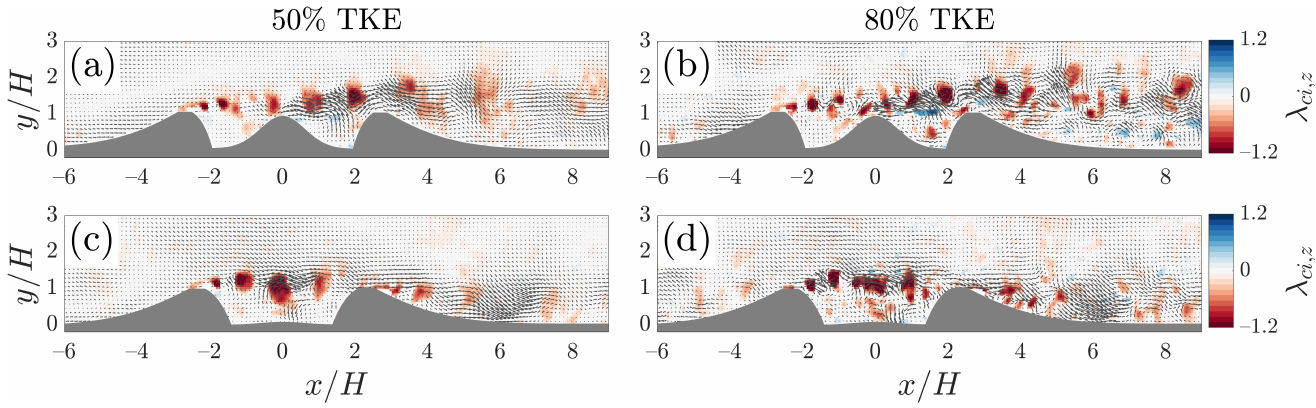
Figure 16. Contours of representative instantaneous spanwise swirling strength, λ ci , z , for the high-speed case in the ( a , b ) centerline wall-normal measurement plane and ( c , d ) spanwise offset wall-normal measurement plane. The fields were reconstructed with numbers of modes corresponding to 50% ( left column ) and 80% ( right column ) of the total kinetic energy. Vectors show the corresponding fluctuating velocity components u (cid:48) and v (cid:48) at every other grid point. Re H = 8.9 × 10 3